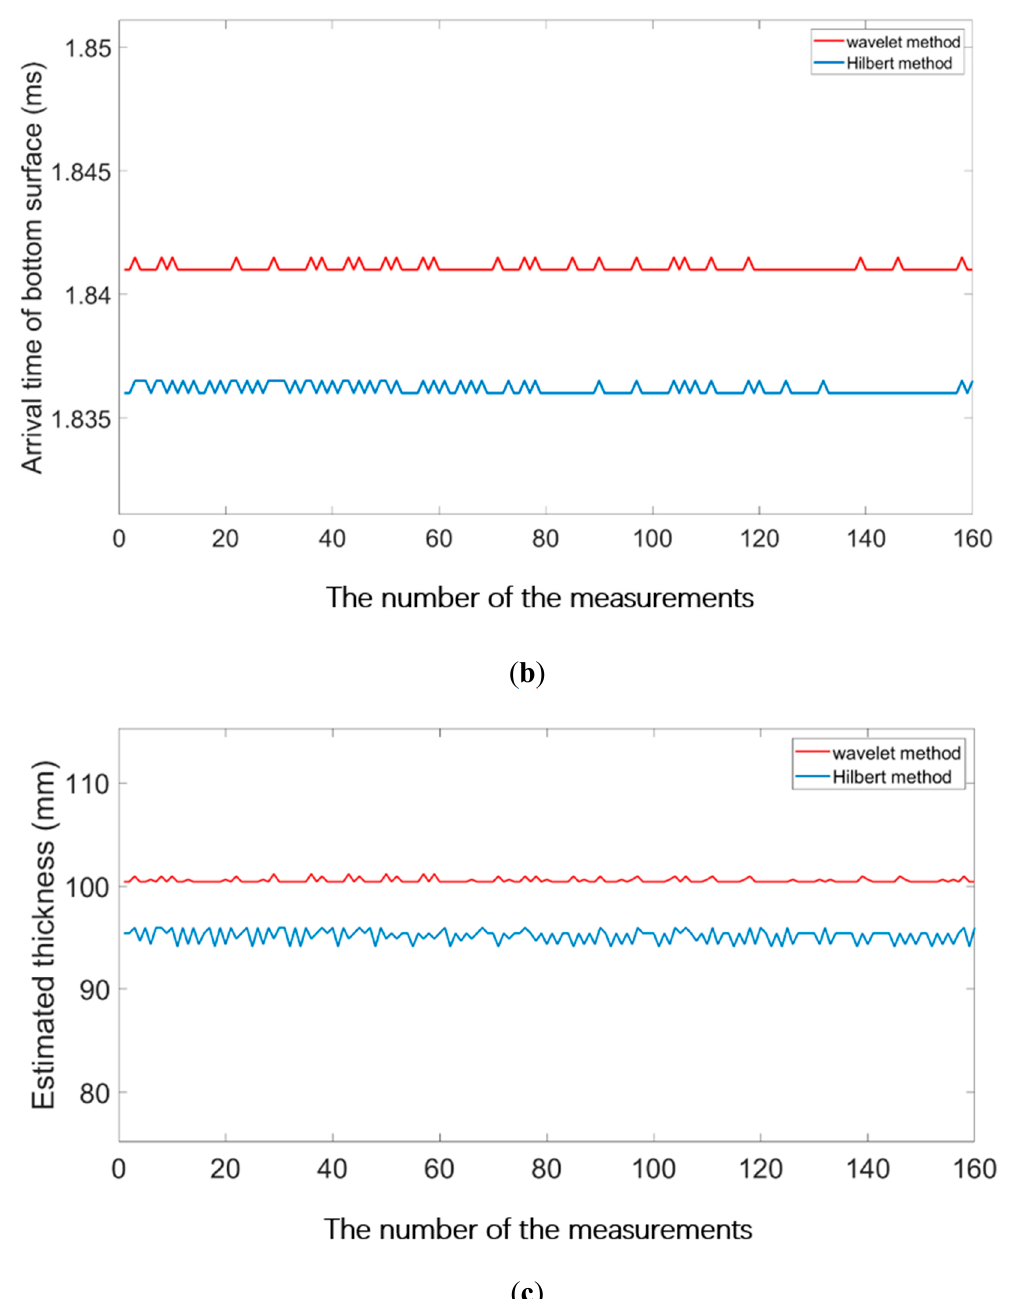
Figure 6. The processing results of the laboratory experiment by different envelope extraction method: ( a ) The arrival time of the top surface; ( b ) The arrival time of the bottom surface; ( c ) The estimated thickness.